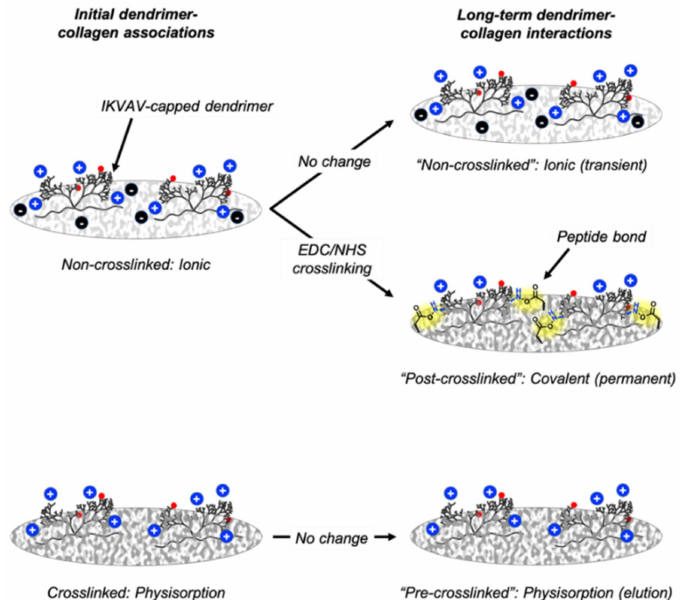
Figure 11. Chemical interactions between dendrimers and non-crosslinked, pre-crosslinked and post-crosslinked films. Red spheres depict Atto dye, blue spheres depict positively charged free amines on IKVAV-capped dendrimers, black spheres depict negatively charged glutamate/aspartate residues on non-crosslinked collagen, and yellow highlights dendrimer-collagen covalent